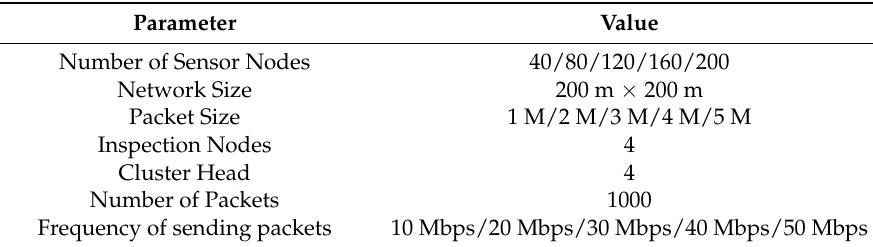
Table 3. Simulation